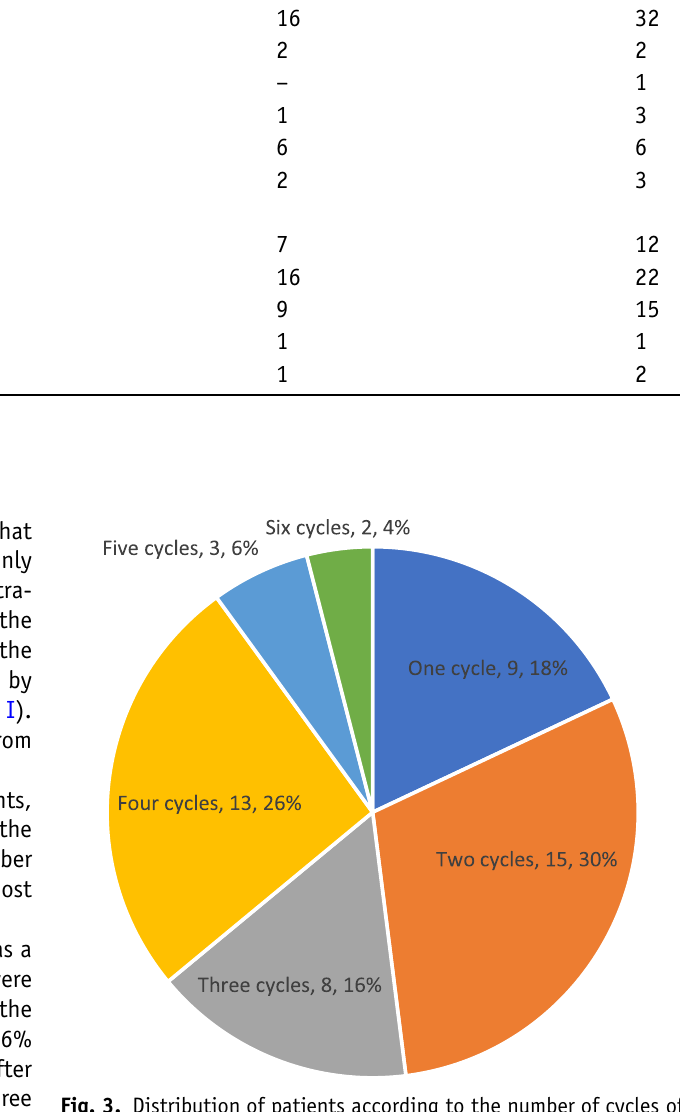
Periorbital/zygoma